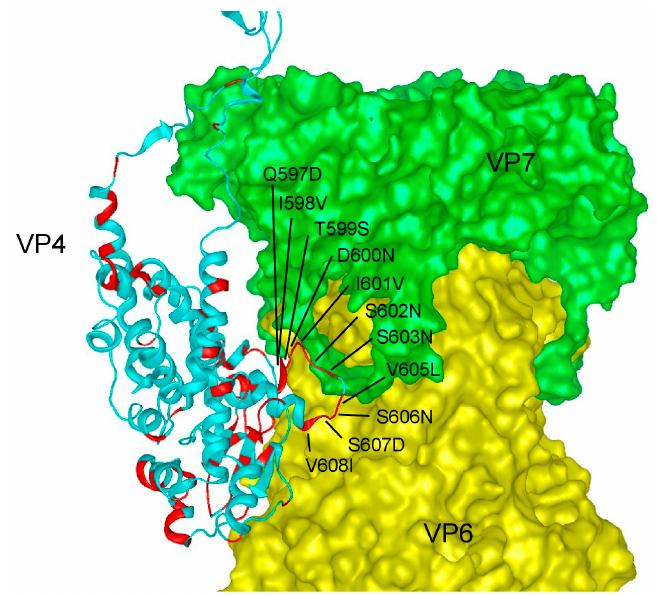
Figure 6. Location of the identified amino acid differences between VP4-SA11 and VP4-Wa in the VP4 foot. Amino acid differences were mapped onto the atomic model of an infectious rhesus rotavirus particle on the basis of PDB 4V7Q [5]. A side view of a VP4 monomer (chain BX) with a VP7 trimer (chains BO, BP, and BQ) and a VP6 trimer (chains AL, AM, and AN) is shown. Amino acid residues in VP4-Wa differing from VP4-SA11 are highlighted in red. Amino acid changes in a VP4 loop close to VP7 and VP6 are labeled.